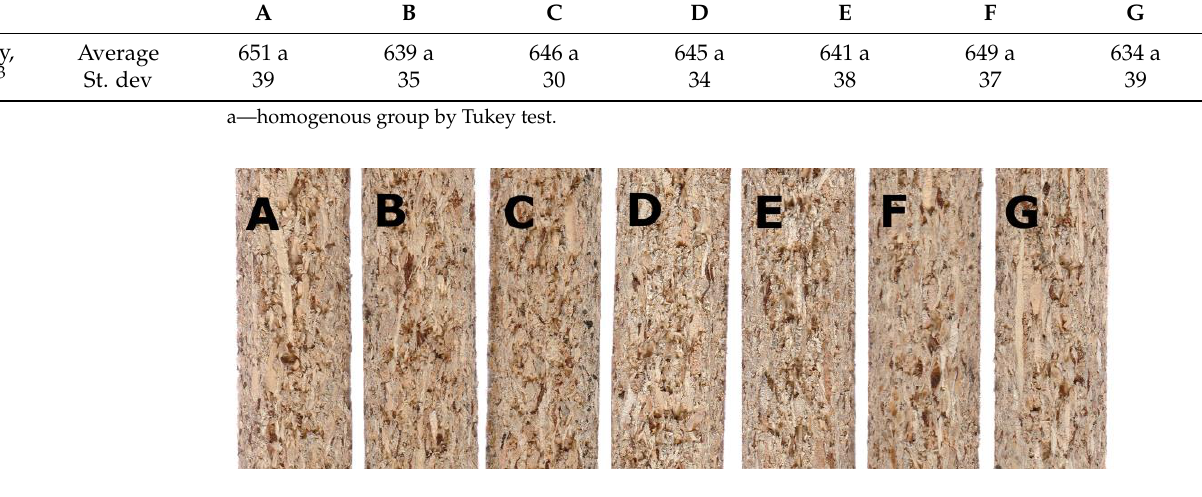
Figure 2. Cross-section of the manufactured particleboard variants. ( A – G ) letters designations according to the variant letters in Table 2.